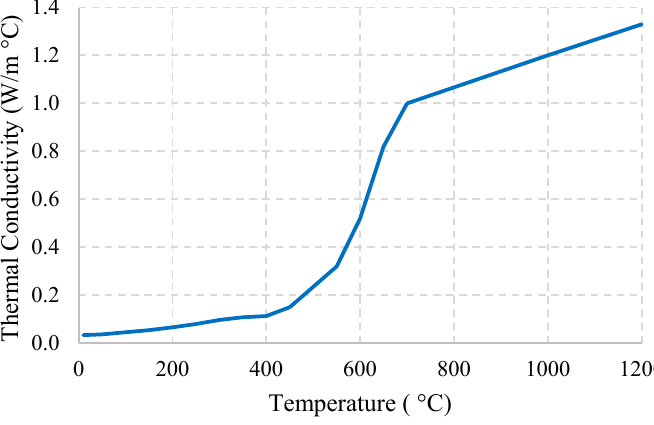
Figure 4. Thermal conductivity of mineral wool [49].